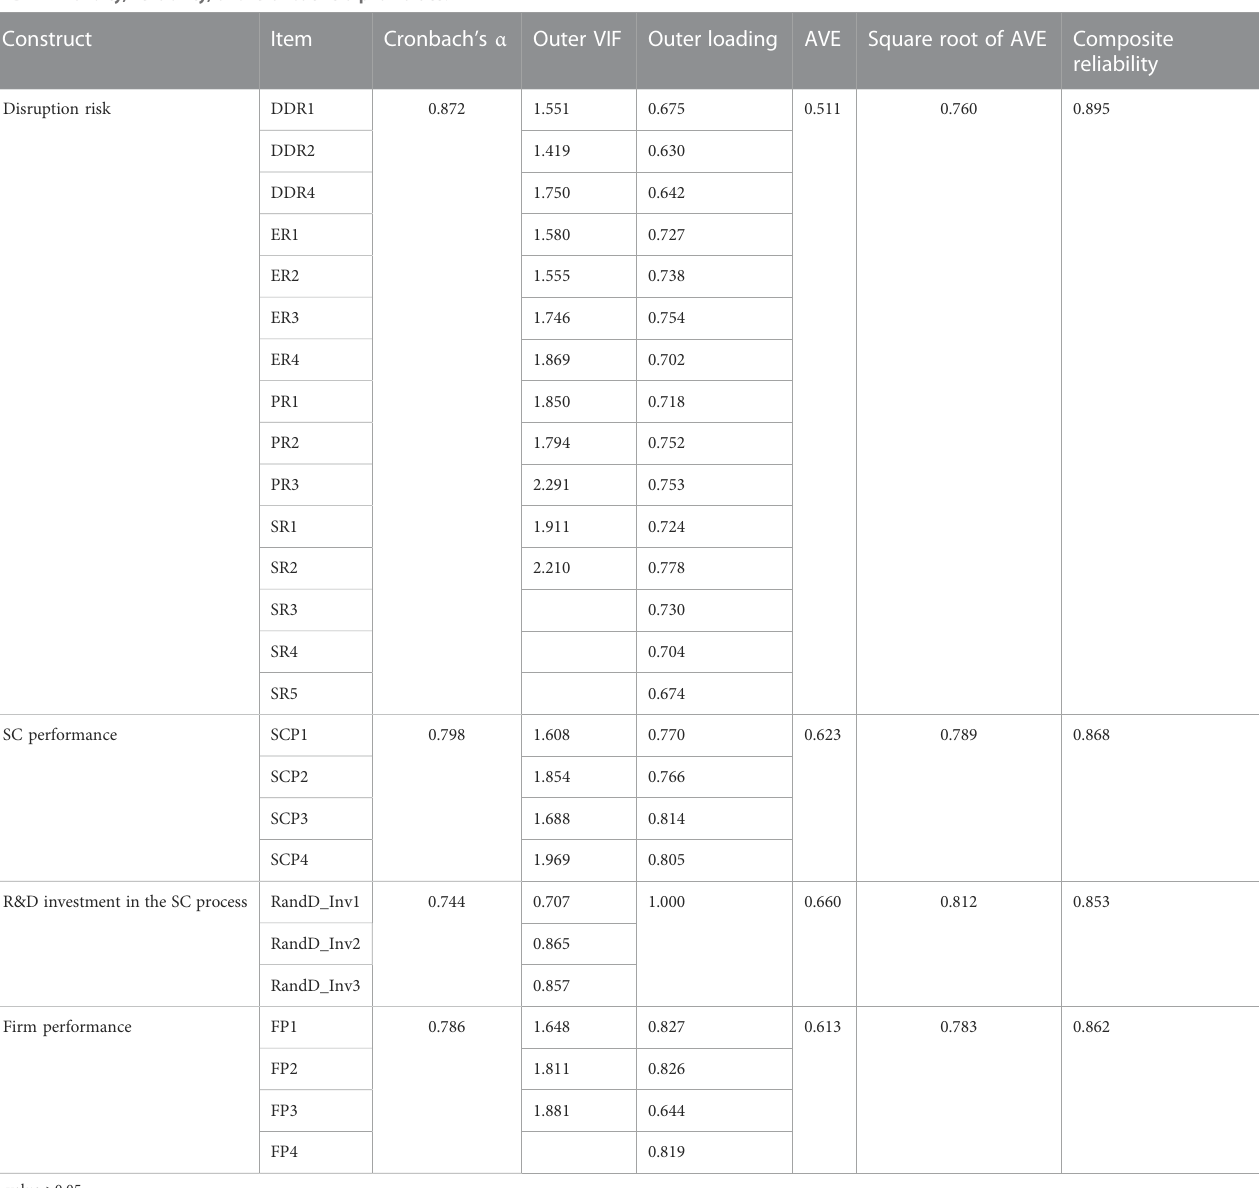
TABLE 2 Validity, reliability, and Cronbach ’ s alpha values.